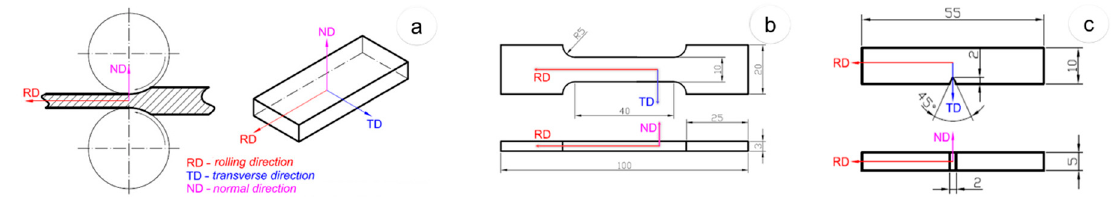
Figure 1. Schematic representation of the applied thermomechanical processing route.